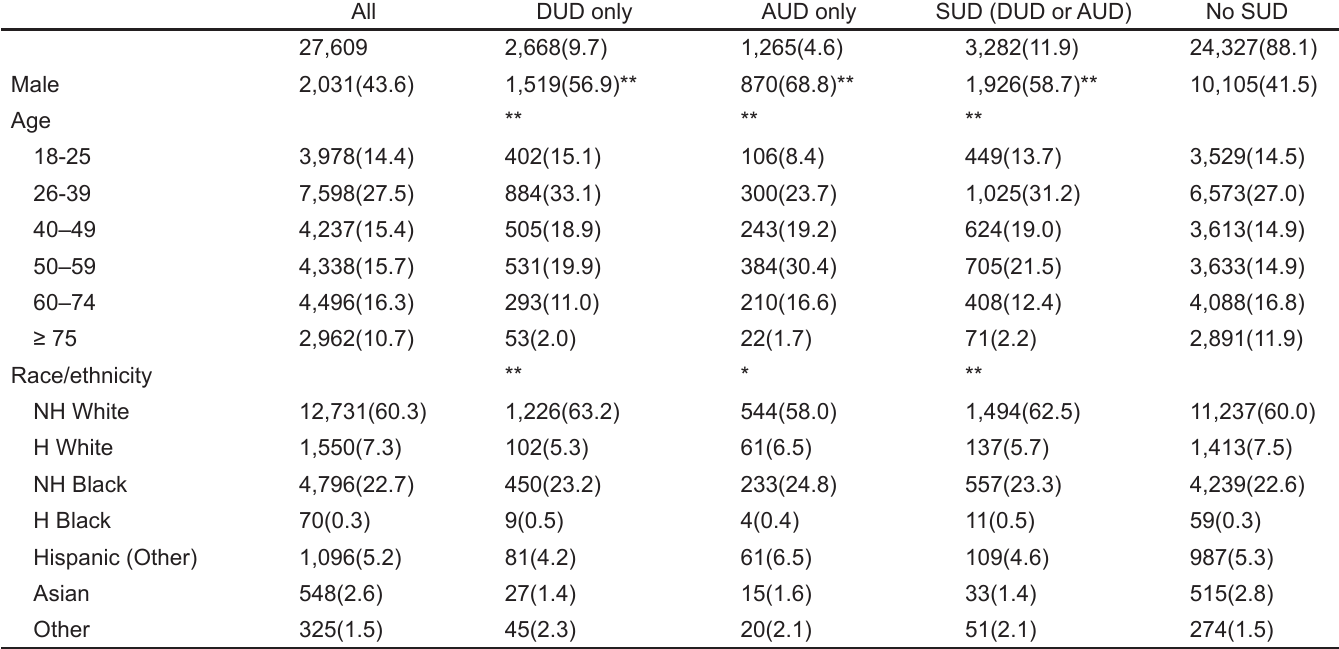
Table 1. Baseline characteristics of patients presenting to the emergency department, stratified by alcohol/ drugs substance use disorder, *NHAMCS 2016–2017(unweighted